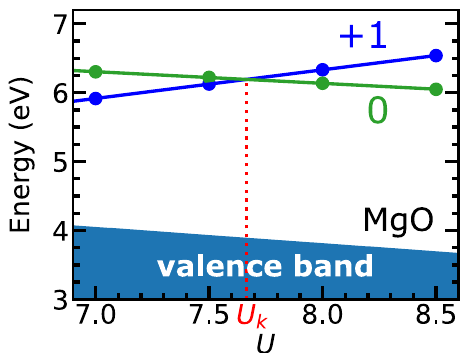
Fig. 1 Enforcement of the piecewise linearity. Energy levels ϵ U 0 Þ as a function of U for the self-trapped hole in MgO. The and ϵ U p ð defect levels are identi fi ed by their respective charge. The value U k is 1 Þ ¼ ϵ U k 0 Þ found such that ϵ U k p ðþ p ð